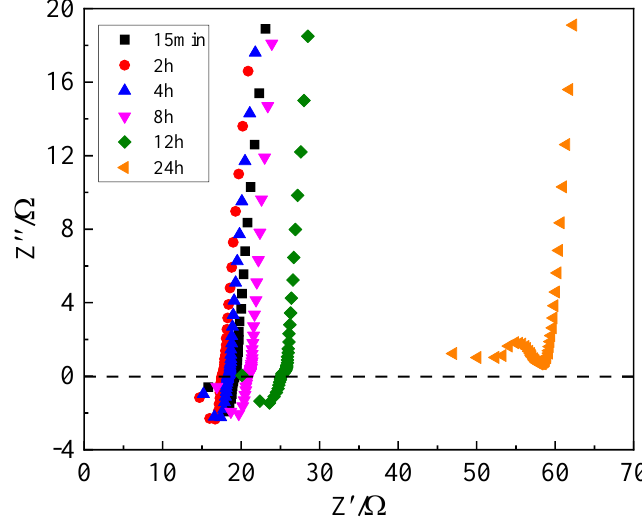
Figure 1. Nyquist plots of ordinary cement paste.